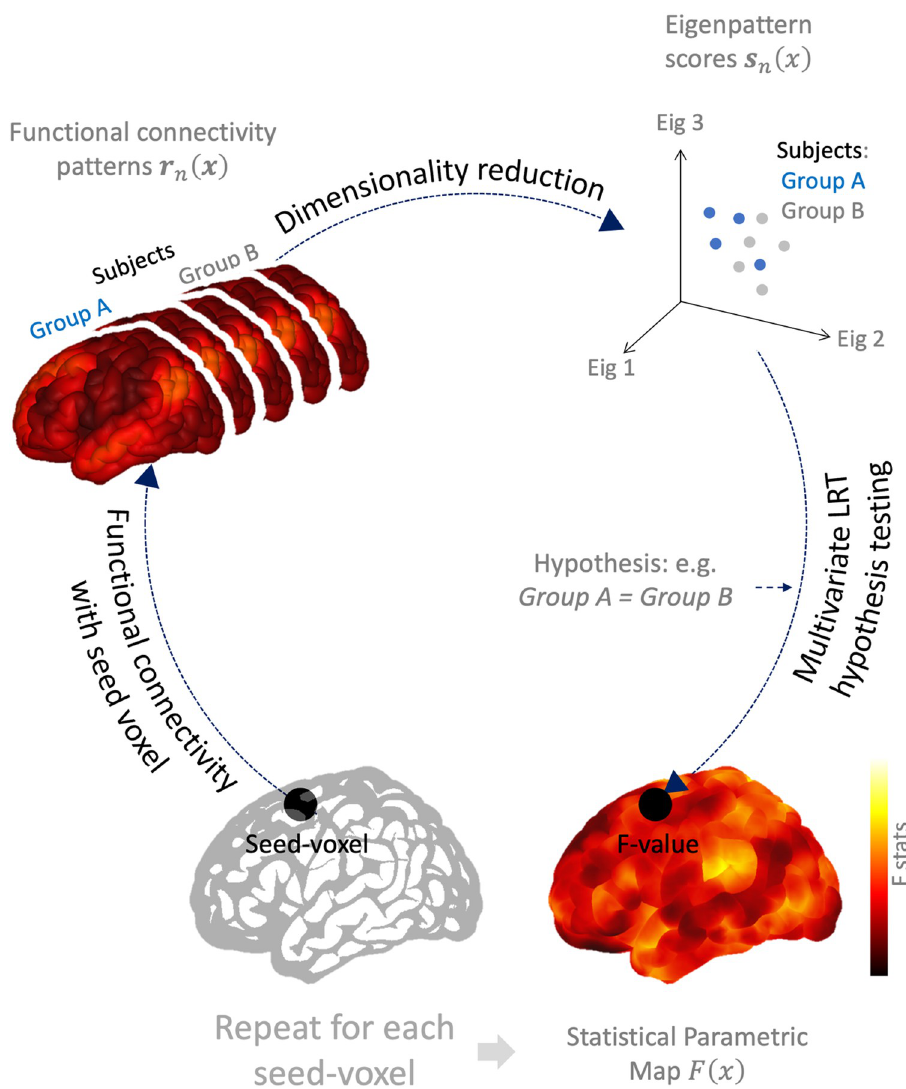
Fig 1. Schematic representation of functional connectivity multivariate pattern analyses (fc-MVPA). For each voxel, fc-MVPA analyses compute the functional connectivity maps between this seed/source voxel and the entire brain (Top-left; r ( x ) in Eq 2) separately for each individual subject. Each subject functional connectivity map is then n characterized by a lower dimensional eigenpattern scores (dots in top-right graph; s n ( x ) in Eq 5). This representation is chosen in a way that captures as well as possible the observed voxel-specific variability in functional connectivity maps across subjects. A multivariate test is then performed on the resulting lower-dimensional eigenpattern scores to ascertain potential between- or within- subjects effects of interest (e.g. differences between subjects or between conditions in functional connectivity at the original seed/source voxel). This process is then repeated for every source voxel to identify regions that show brain-wide between- or within- subjects differences in functional